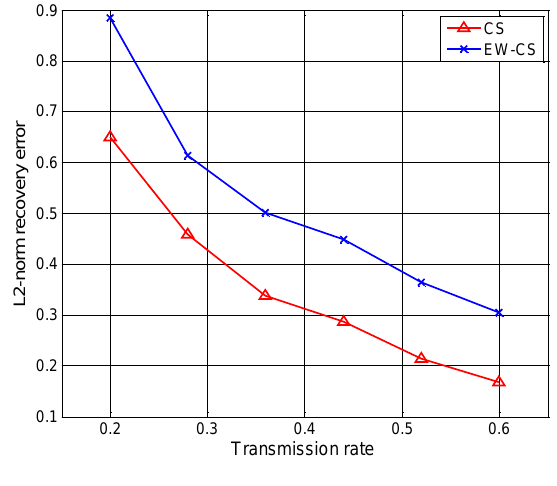
Figure 15. The l -norm recovery error with different transmission 2